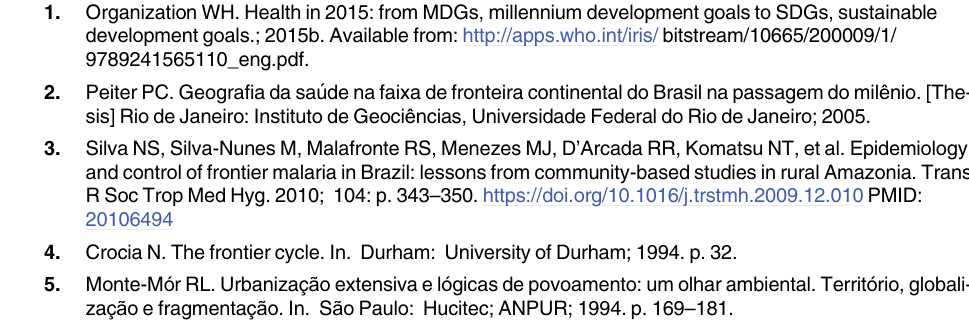
S1 Table. Annual Parasite Index (API) and Plasmodium species according to year and